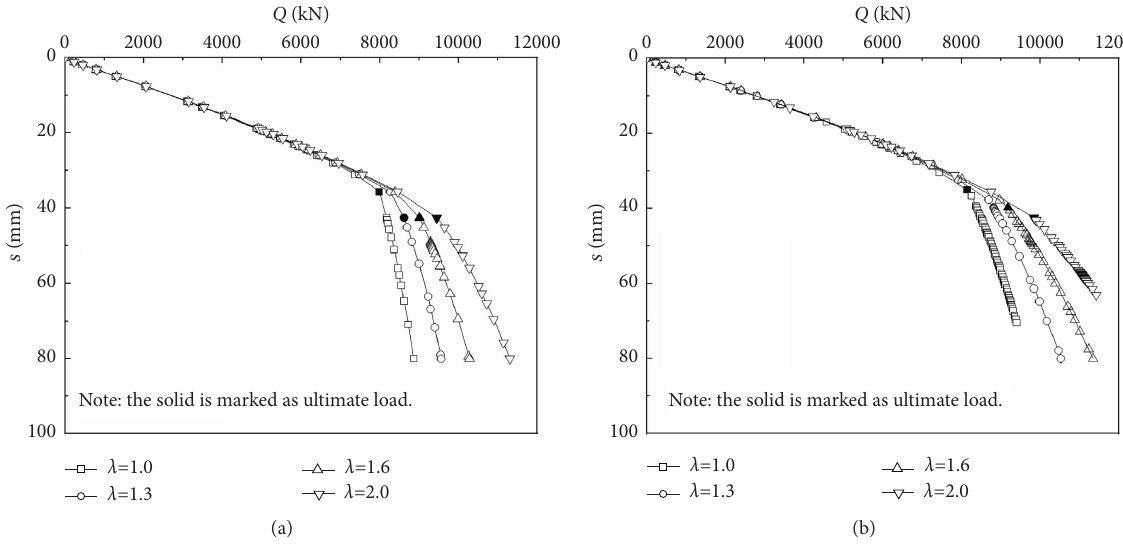
Figure 12: Influence of the expansion ratio of the enlarged base and bearing layer. (a) End bearing layer, ⑦ silt mixed silty clay. (b) End bearing layer, ⑧ silty